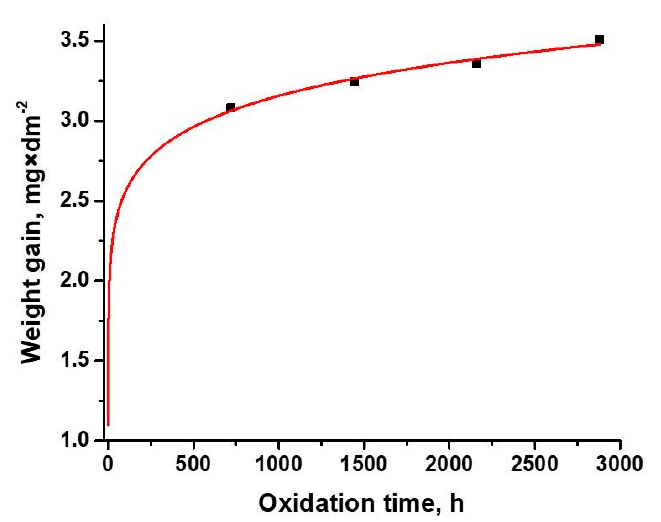
Figure 1. Oxidation kinetics of 310 H samples in supercritical water. From this figure, it was observed that, over time and due to oxidation, all